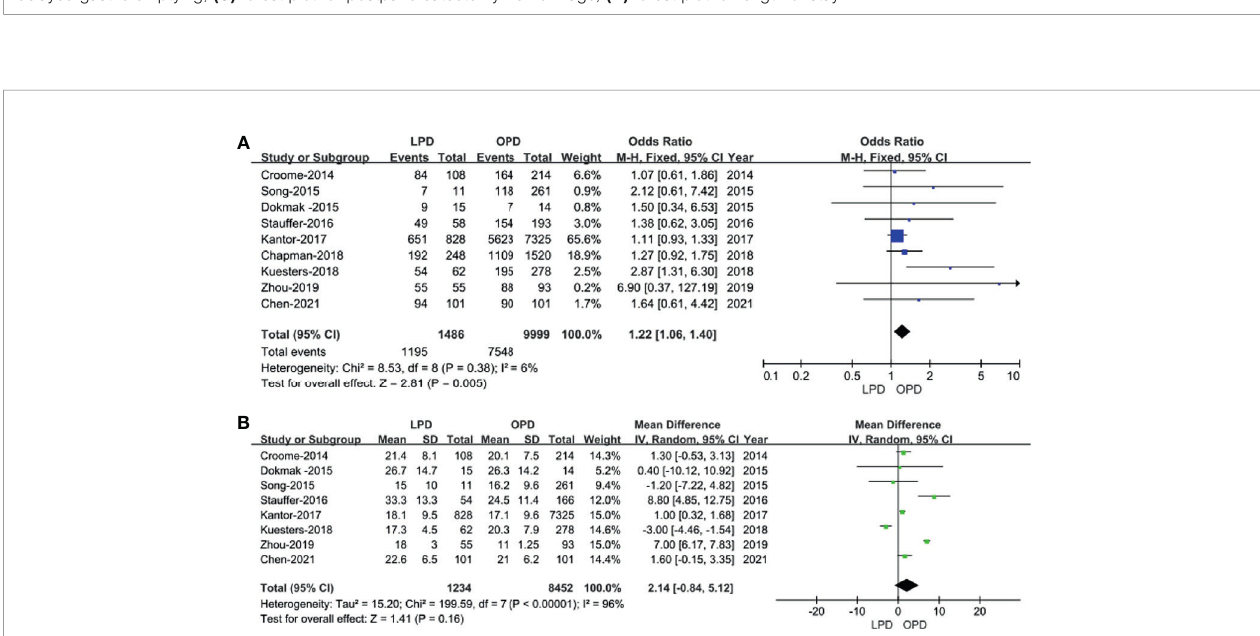
FIGURE 5 | Forest plot of the comparison of LPD versus OPD for short − term oncological outcomes. (A) Forest plot for R0 resection rate; (B) forest plot for lymph node dissection.